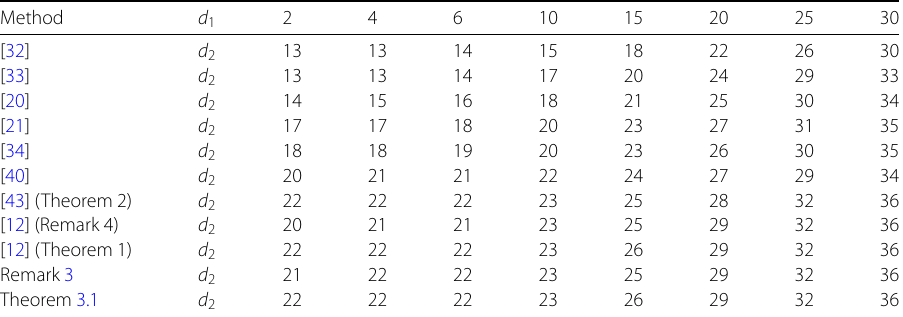
Table 1 Allowable delay upper bound d 2 for various d 1 for Example 1 Method d 1